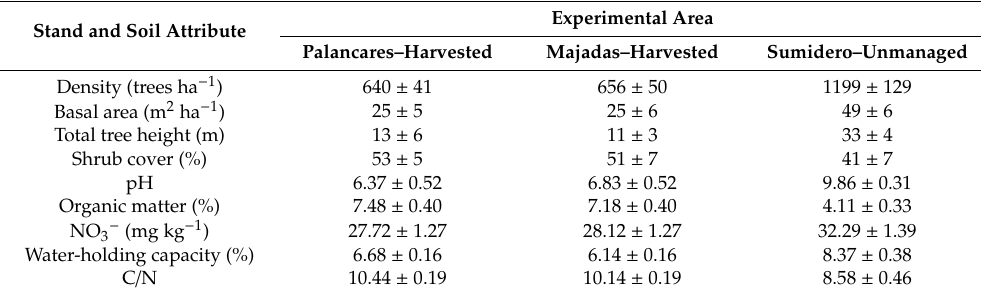
Table 1. Mean and standard error for selected stand and soil characteristics (measured at a depth of 30 cm) at three experimental Spanish black pine stands (Cuenca Mountains, Spain) after tree harvesting in late December